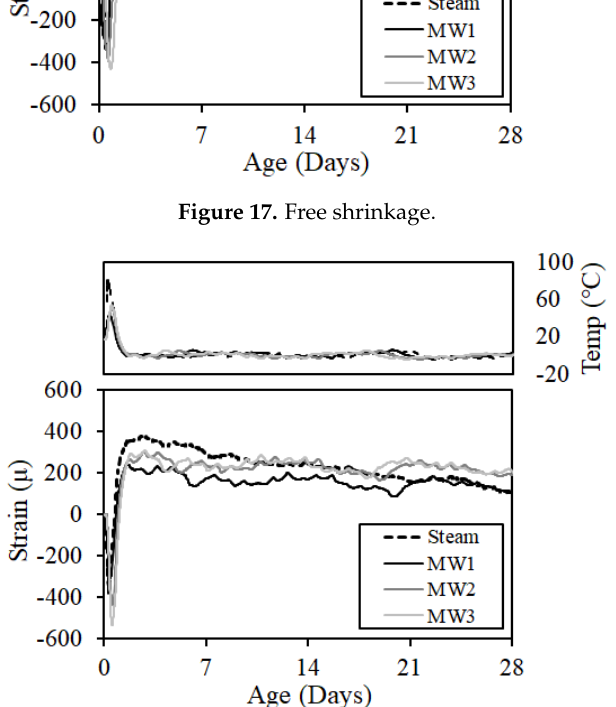
Figure 18. Restraint shrinkage.